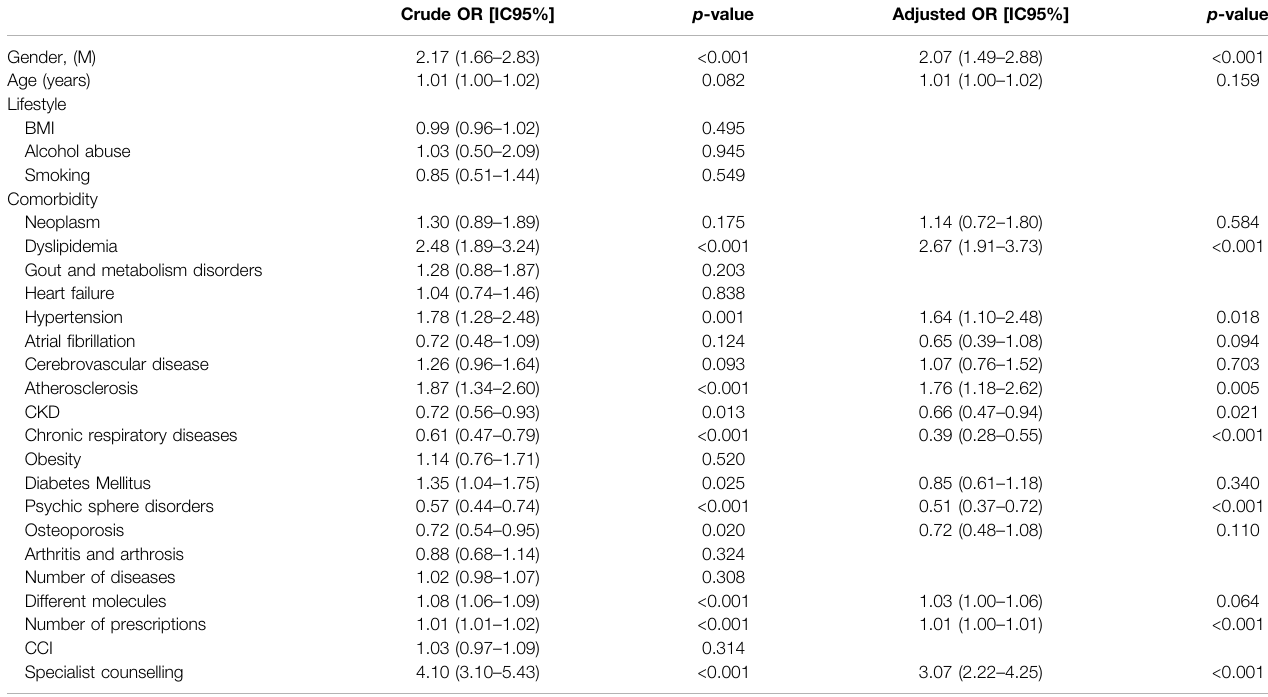
TABLE 2 | Predictive factors of recommended treatment use in CAD affected patients. Crude OR